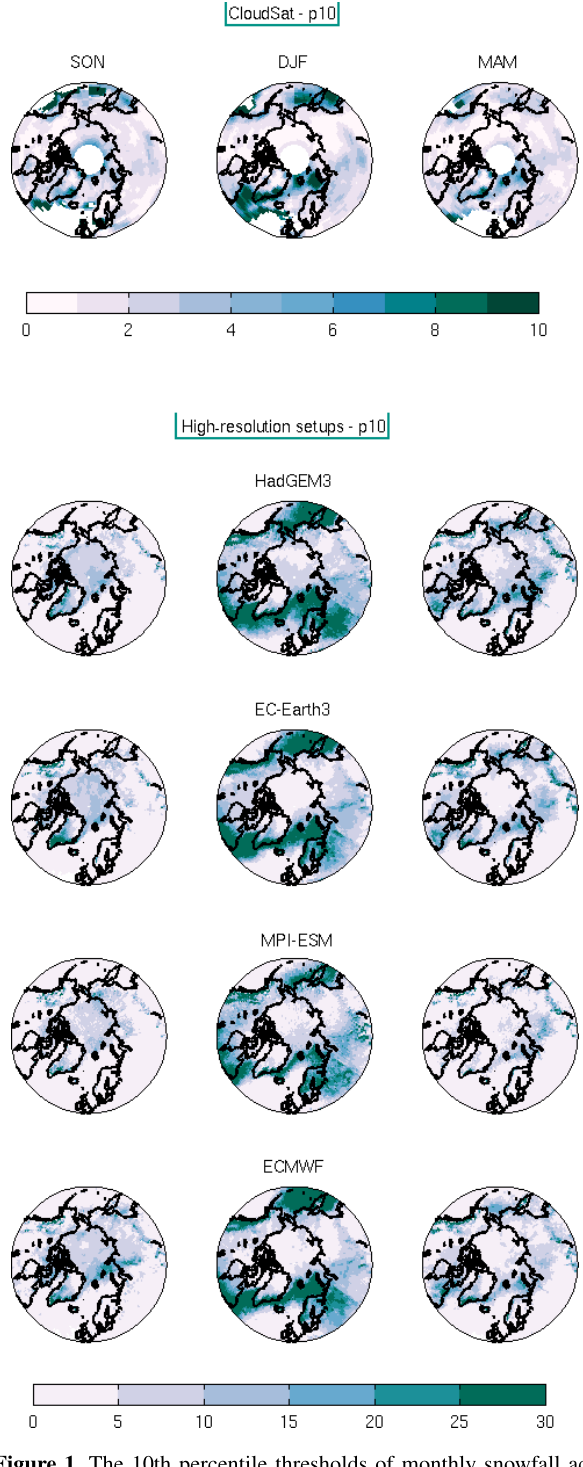
Figure 1. The 10th percentile thresholds of monthly snowfall ac- cumulations (mmmonth − 1 ) for the SON, DJF and MAM months in the three columns, respectively. The top row shows the CloudSat observations and the other four rows below show snowfall from the Hi-res setups of HadGEM3, EC-Earth3, MPI-ESM and ECMWF,